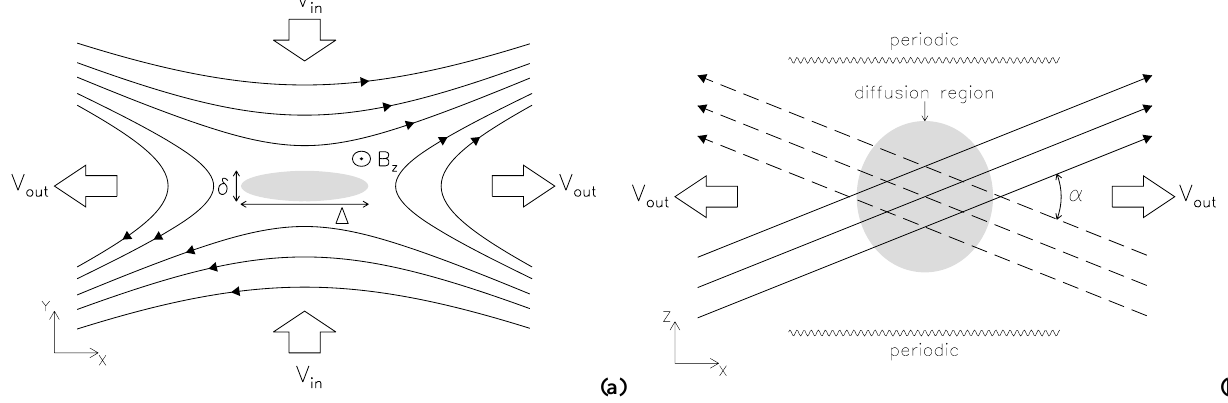
Fig. 2. A schematic of our magnetic field configuration projected on the XY (a) and XZ (b) planes. (a) XY projection of the magnetic field lines. The gray area describes the diffusion region where the incoming field lines reconnect. The longitudinal and transverse scales of the diffusion region are given by 1 and δ , respectively. We use outflow and inflow boundary conditions in the ˆ x and ˆ y directions, respectively. (b) XZ projection of the magnetic field lines as seen from the top. Solid and dashed lines show the incoming field lines from the upper and lower parts of the domain, respectively. We see that the oppositely directed field lines are not anti-parallel but are set as an angle α determined by the strength of the shared component B z . The ˆ z boundary conditions can be open or periodic, depending on the model (from Kowal et al.,